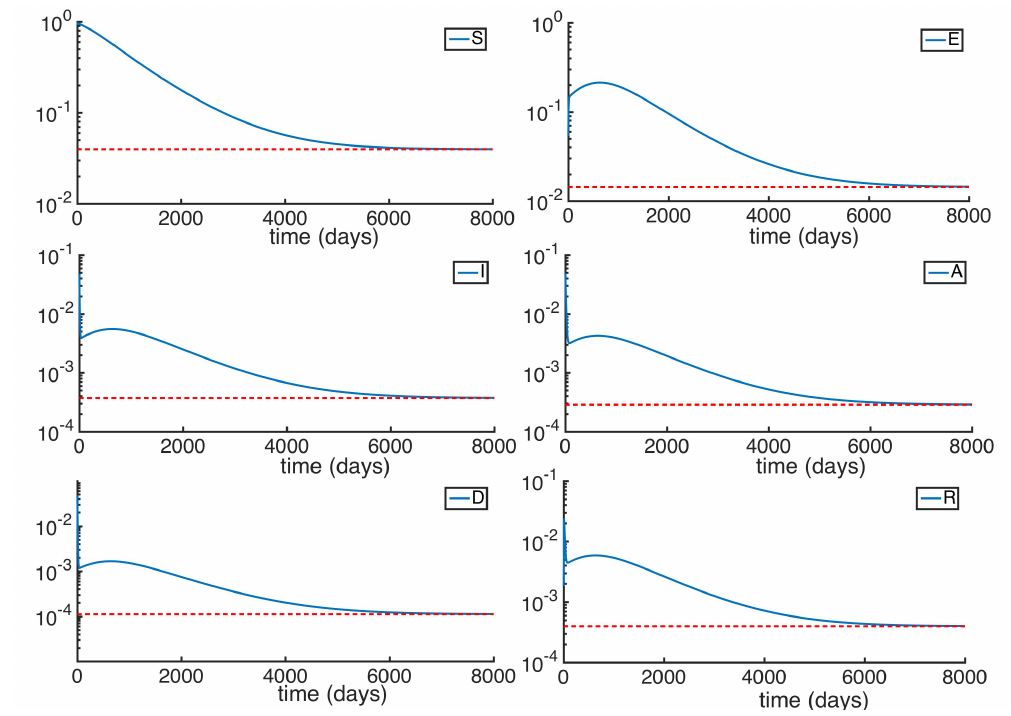
Figure 4. A better display of the different subpopulations for a R 0 = 1.39.